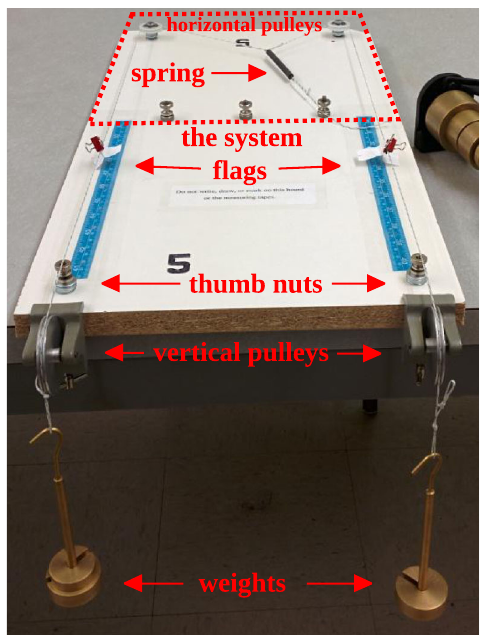
FIG. 1. The partial derivative machine. The machine consists of a system (inside the dotted quadrilateral) which may be manip- ulated by pulling on two strings. Each string features a flag, which may be used to measure its position, and a hanger for weights ranging from 10 to 250 g which may be used to fix the tension in the string. In addition, thumb nuts may be used to fix the position of each string